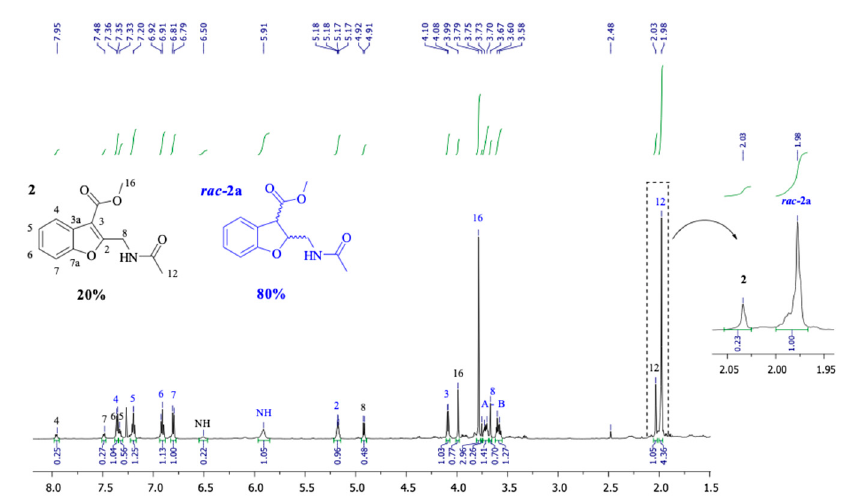
Figure 2. 1 H-NMR spectrum (CDCl 3 ) of the crude reaction (entry 6, Table 2).